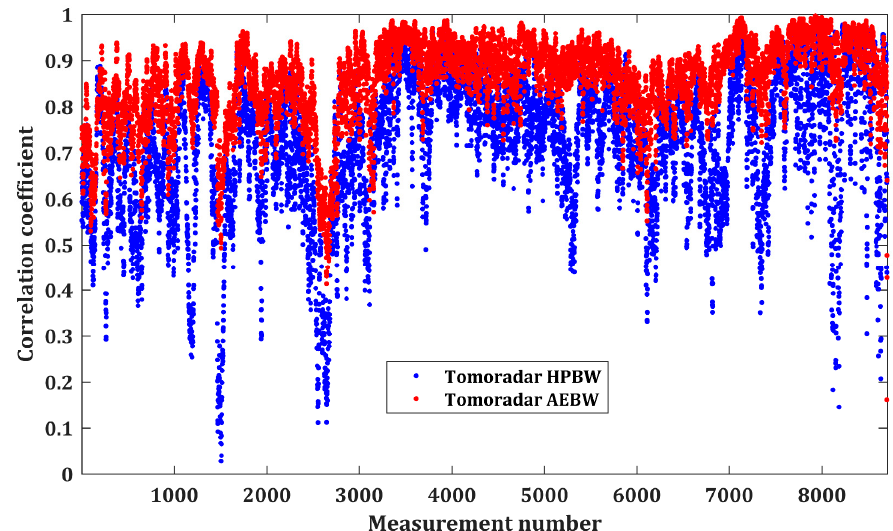
Figure 14. The distribution of correlation coefficients between Tomoradar waveforms and simulated- waveforms generated from lidar points within Tomoradar HPBW and average effective beamwidth (AEBW).